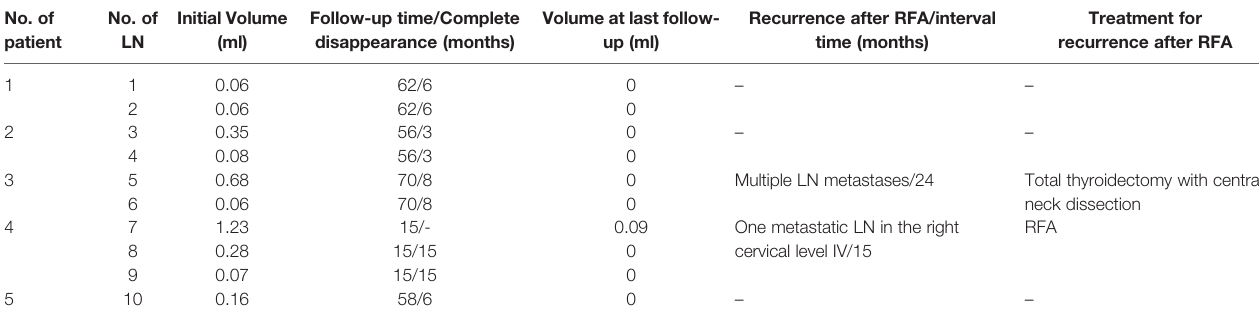
TABLE 2 | Outcomes of RFA for metastatic LNs in pediatric patients with PTC. No. of No. of patient